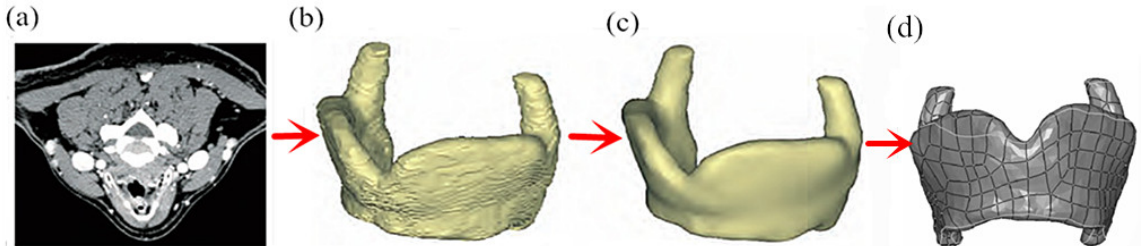
Figure 3. Design process of solid thyroid cartilage: ( a ) CT images; ( b ) reconstructed model; ( c ) model after surface treatment; ( d ) materialized model.